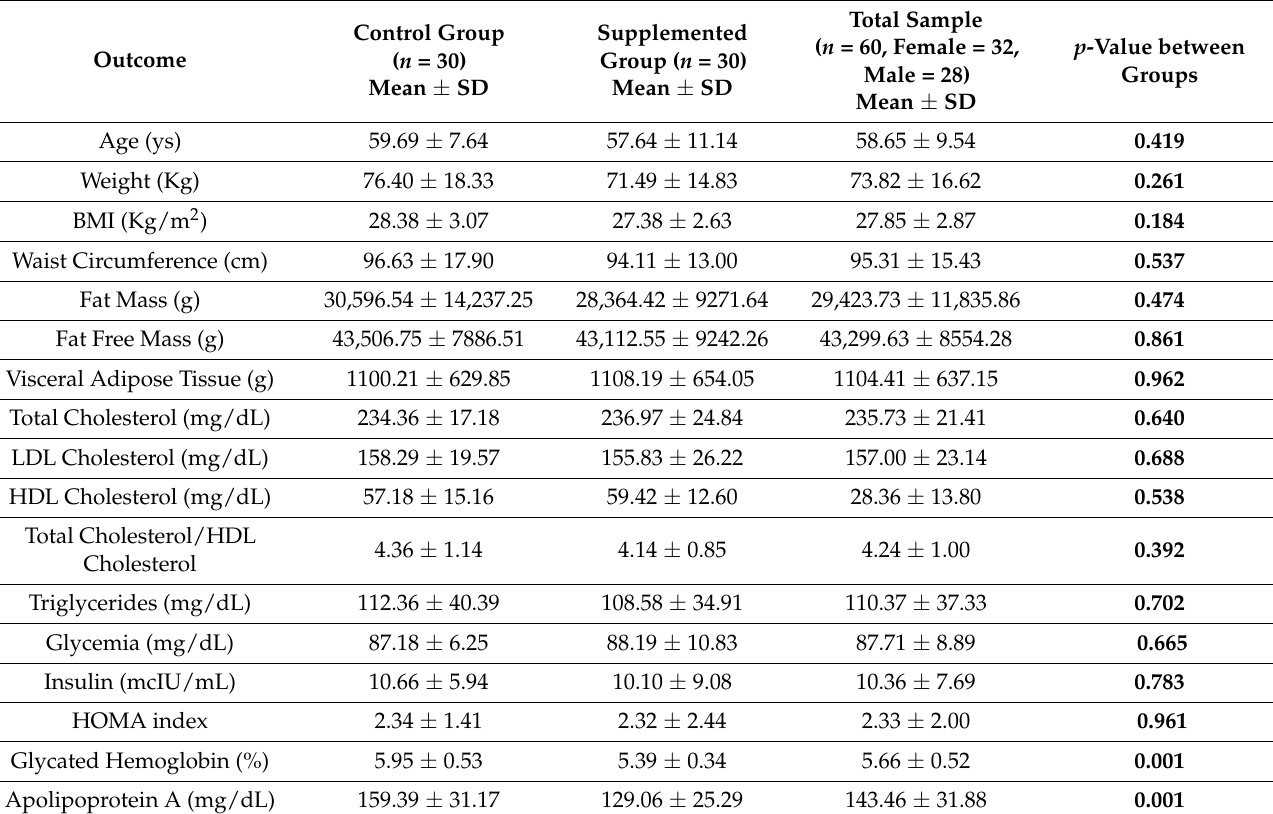
Table 1. Clinical characteristics at